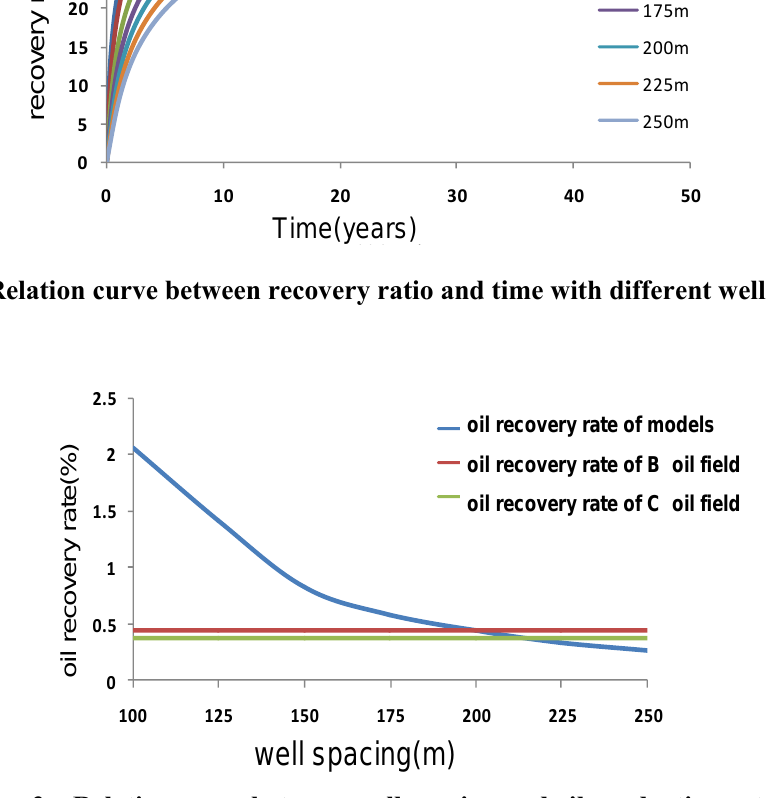
Figure 3—Relation curve between well spacing and oil production